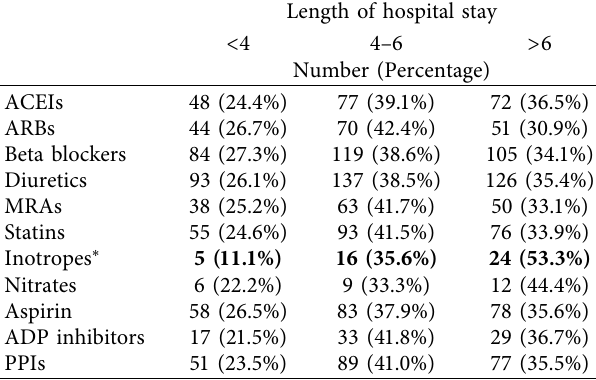
Table 9: Drugs administered for patients during hospitalization divided by the tertiles of LOS. ∗ signifcant between group